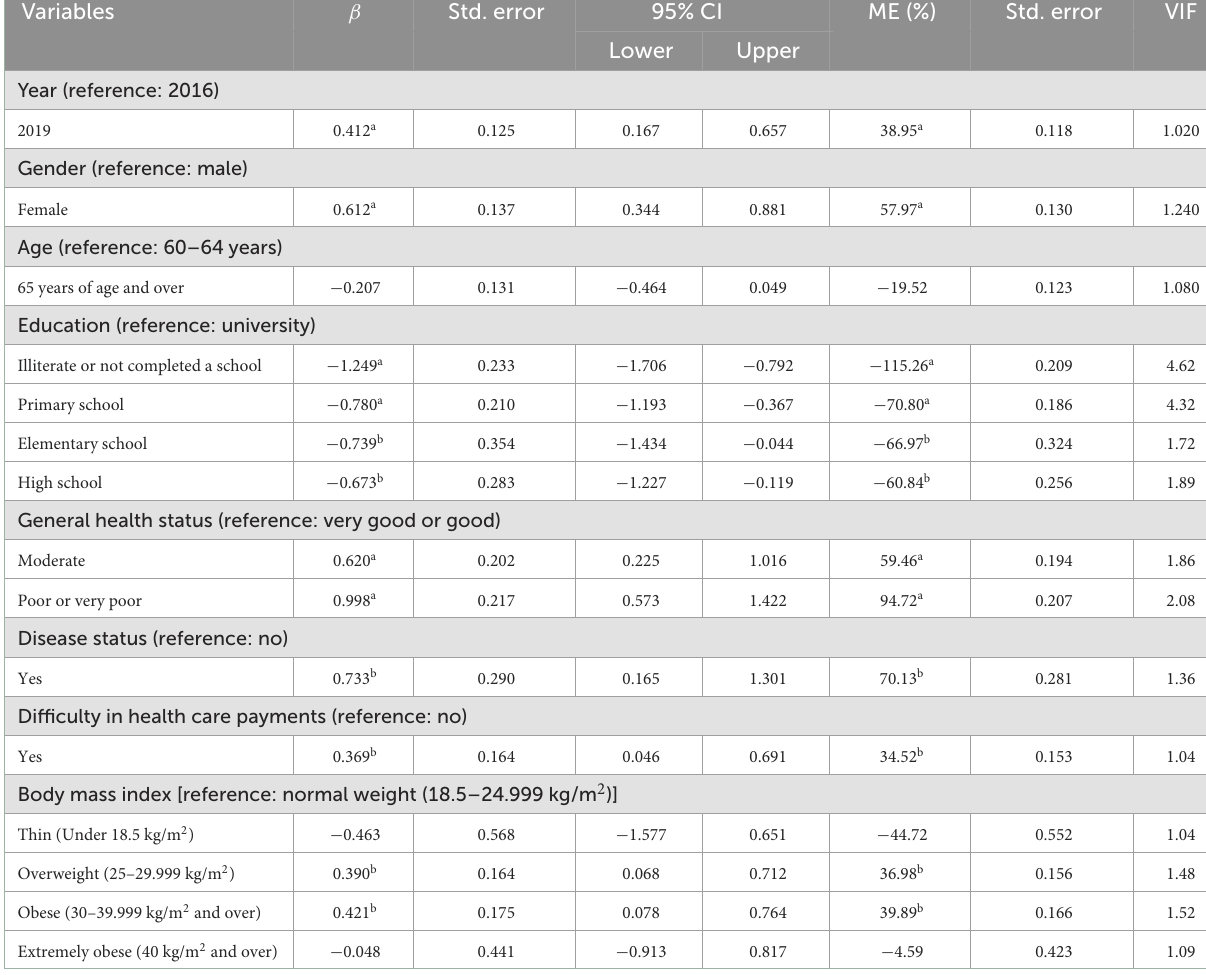
TABLE 2 Estimated model results and marginal effects on factors effective in receiving psychological assistance services for older individuals. Variables